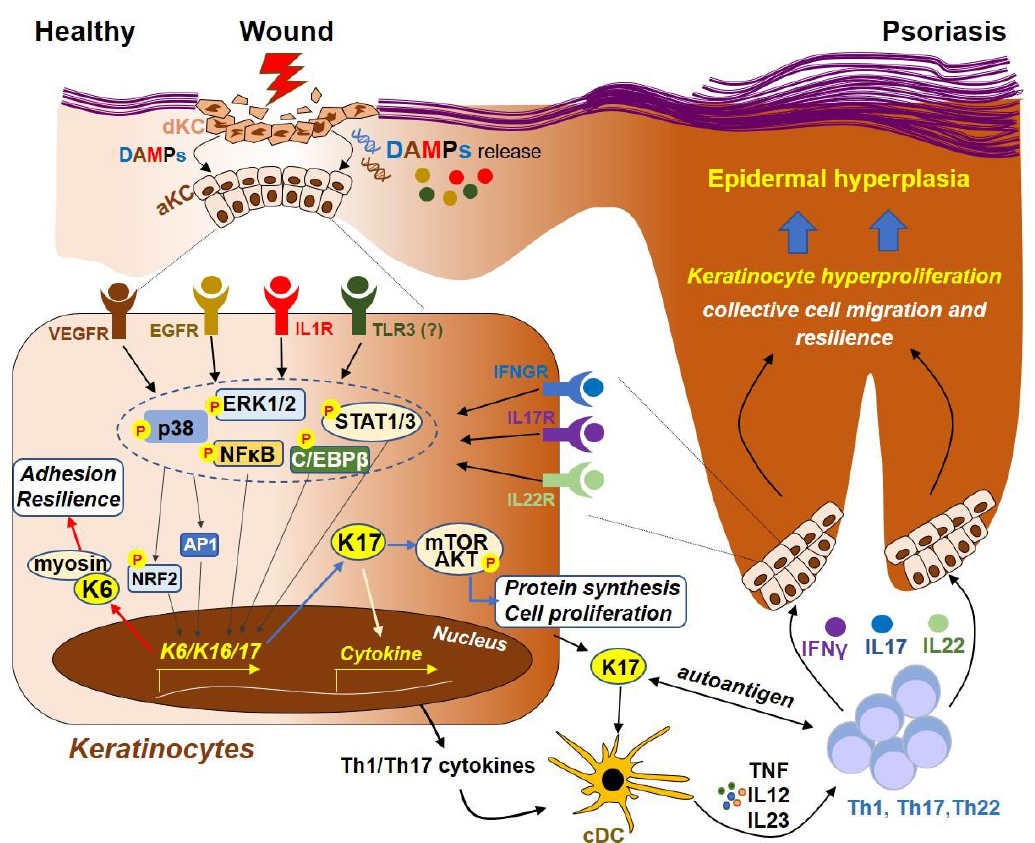
Figure 2. Model for the regulation of Keratin 6, 16 and 17 during skin wounding and in psoriasis. During skin injury, damaged keratinocytes (KCs) release a variety of damage-associated molecular patterns (DAMPs), such as nucleic acids (RNA or DNA) and proteins (such as IL1 β ). Recognition of these DAMPs by their cognate receptors, such as IL1 β by IL1R, EGF by EGFR, dsRNA by TLR3 and / or VEGF by VEGFR, lead to the activation of downstream signaling molecules, including MAPKs (ERK1 / 2 and p38) and transcription factors CEBP β , NF κ B, NRF2 and AP1, which then translocate to the nucleus and mediate the transcription of K6, 16 and 17. K6 protein can interact with myosin IIA, promoting cell adhesion and resilience that is necessary for KCs to resist mechanical stress during wounding. Furthermore, the K17 protein can promote protein synthesis and cell proliferation by activating the mTOR-AKT pathway. K17 can also translocate to the nucleus, regulating the expression of proinflammatory cytokines through chromatin binding and transcription. In addition, peptides derived from K17 can function as autoantigens to activate conventional DCs (cDC), which then secrete cytokines (TNF, IL12 and IL23) that promote Th1, Th17 and / or Th22 T cell activation. T cell-derived cytokines, including IFN γ , IL17A and IL22, can in turn act on their respective cell receptors that are expressed on keratinocytes, leading to activation of the ERK1 / 2 and STAT1 / 3, which further increases the expression of keratin genes, forming an autoimmune positive feedback loop that ultimately drives psoriasis pathogenesis.